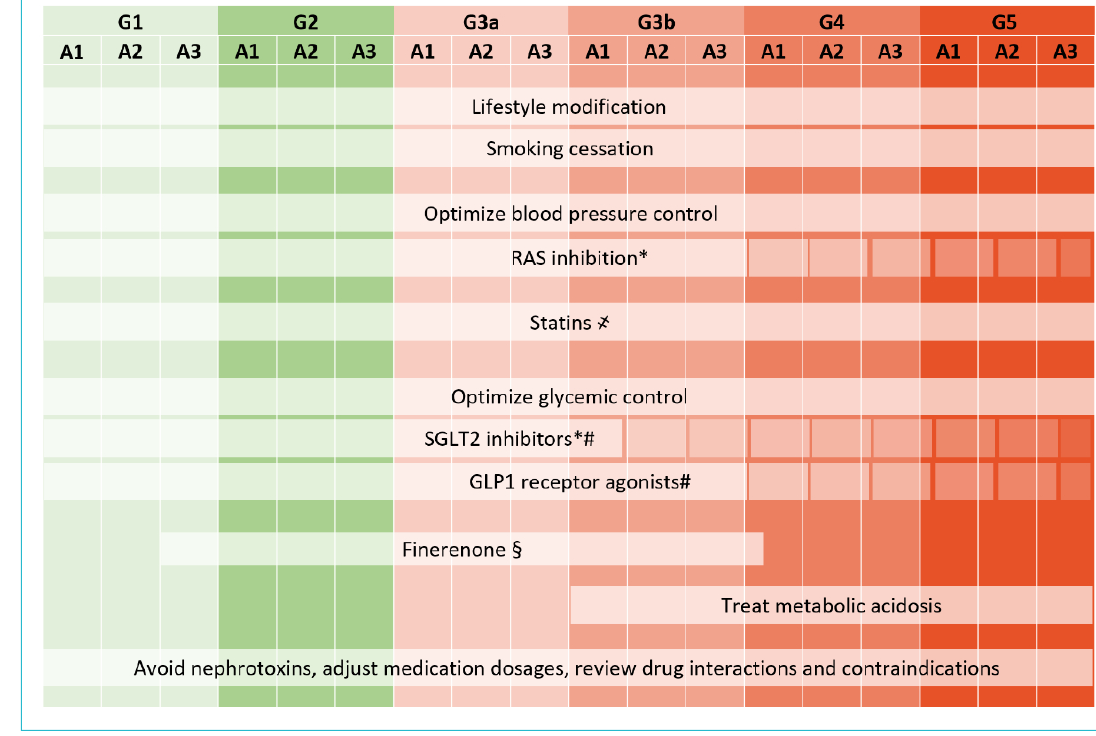
Figure 6: Interventions to slow DKD progression and/or reduce cardiovascular disease (adapted from: Shlipak MG, et al. The case for early identification and intervention of chronic kidney disease: conclusions from a Kidney Disease: Improving Global Outcomes (KDIGO) Controver-